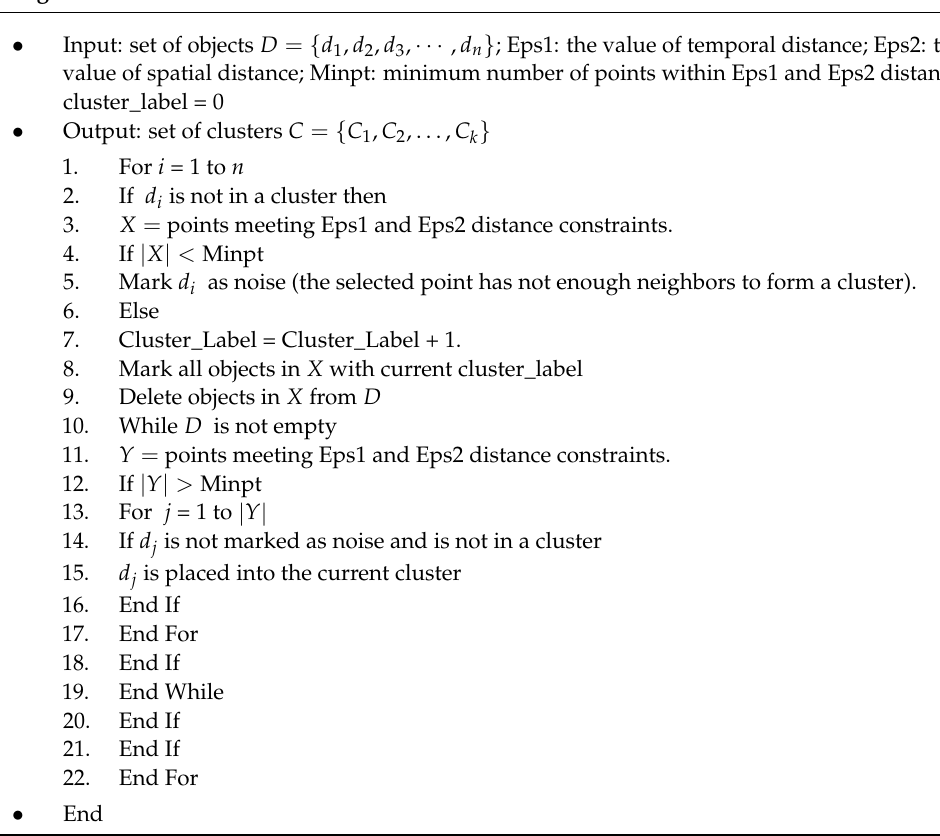
Algorithm 1 ST-DBSCAN